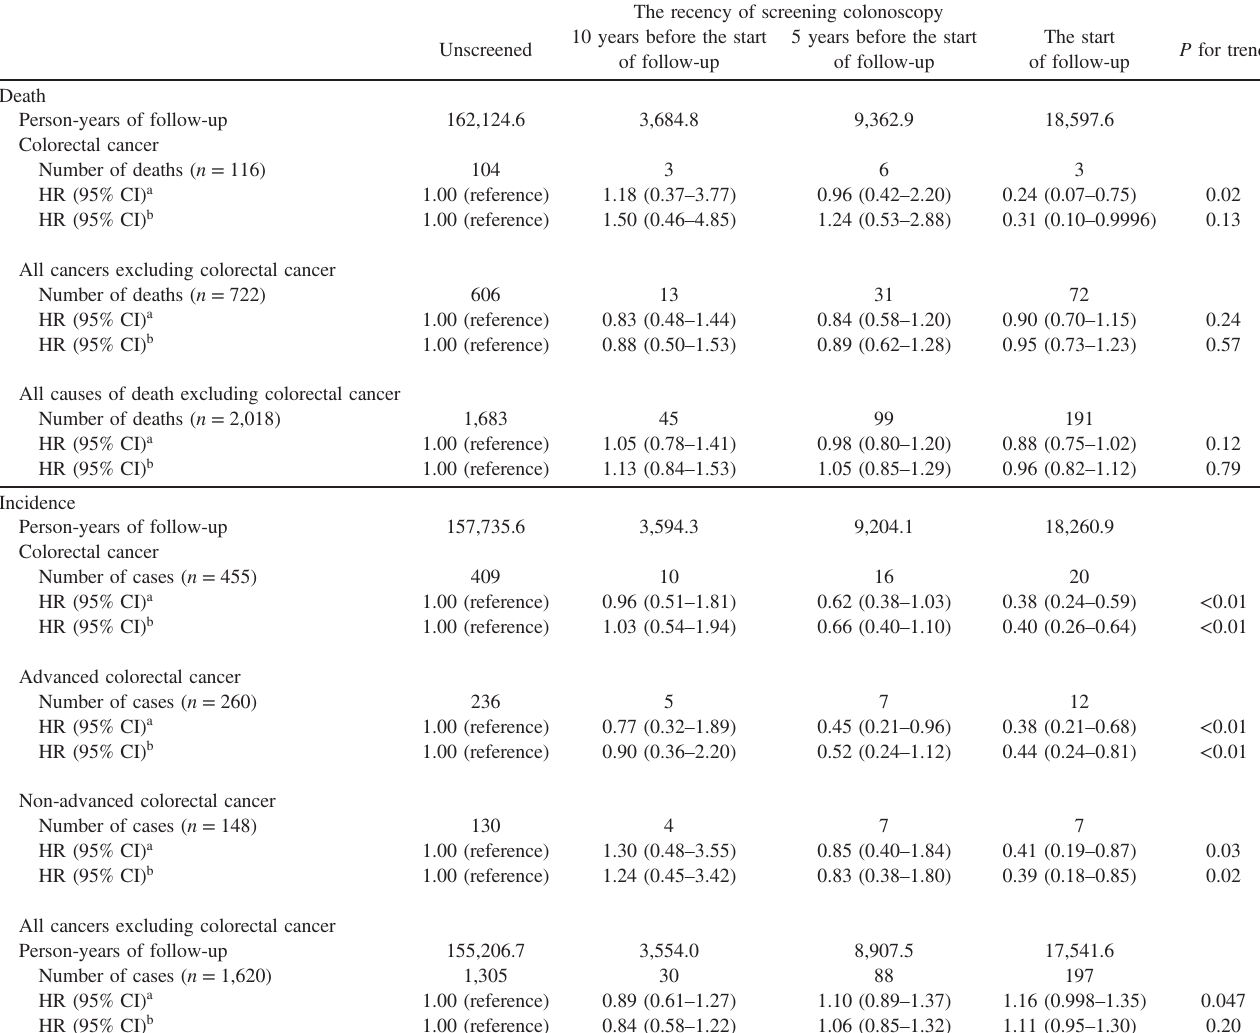
Table 4. Hazard ratio and 95% con fi dence interval for the recency of screening colonoscopy and subsequent risk of colorectal cancer in 14,732 subjects in the JPHC